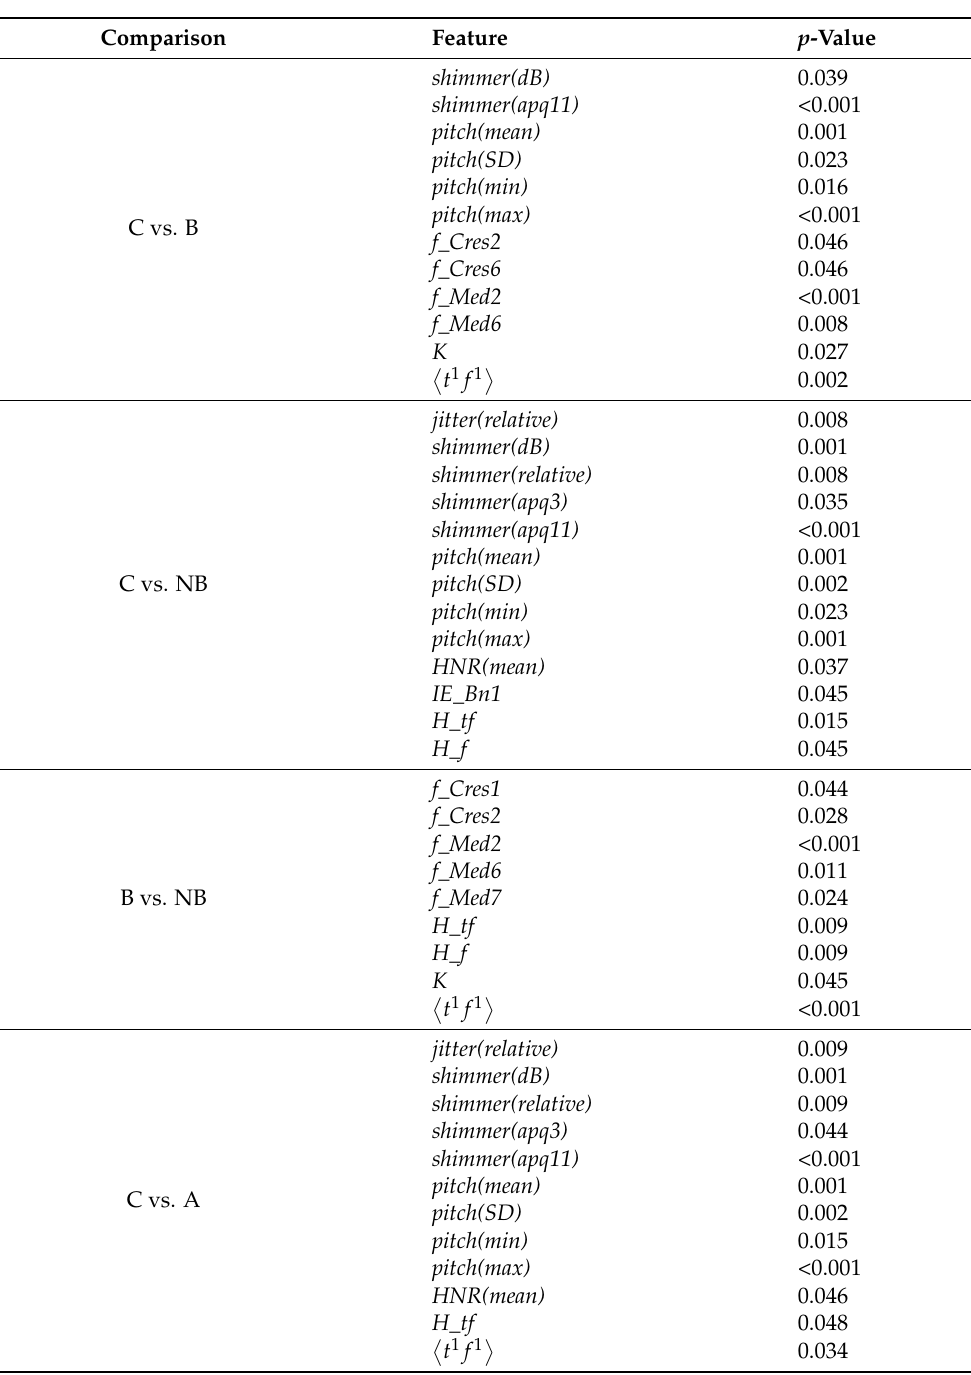
Table 2. Significant Features for